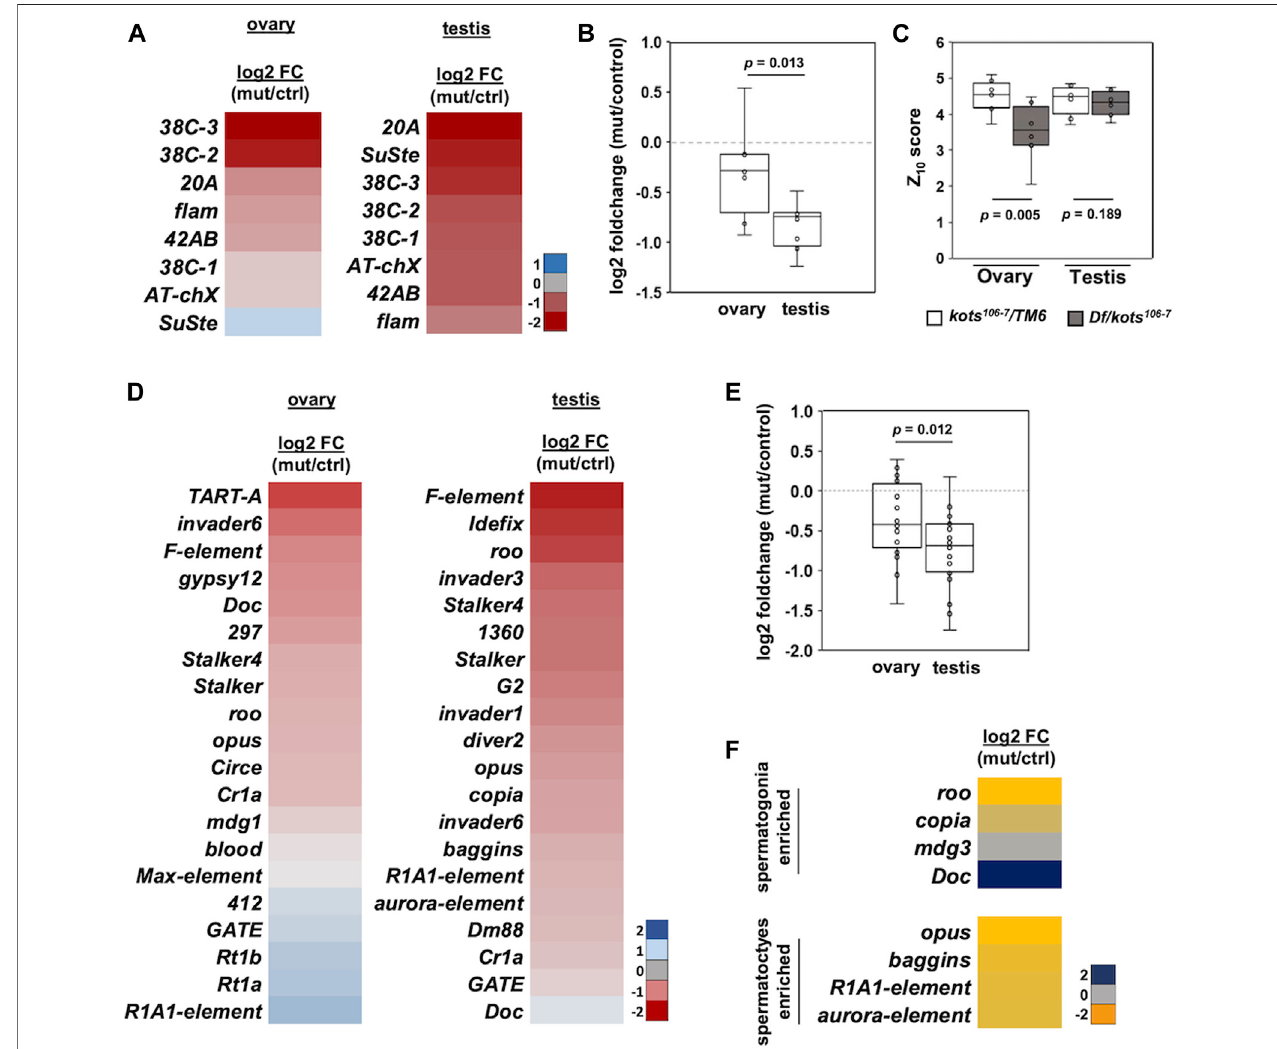
FIGURE 4 | piRNAs mapping to canonical piRNA clusters and transposons are downregulated in kots mutants. (A) Log 2 fold change (mutant/control) of piRNAs mapping to 8 major clusters in mutant and control gonadal samples. (B) Downregulation of cluster-mapping piRNAs is more severe in testes than that in ovaries ( t -test, p -value0.013). (C) BoxplotshowingZ 10 scoreofpiRNAsmappingtoclustersinovariesandtestes( t -test, p -values0.005and 0.189,respectively). (D) Log 2 foldchange of top 20 most abundant TE-mapping piRNAs. (E) Comparison of the top 20 most abundant TE-mapping piRNAs in ovaries and testes ( t -test, p -value 0.012). (F) Log 2 fold change in abundance of piRNAs mapped to TEs enriched in spermatogonia and spermatocytes.